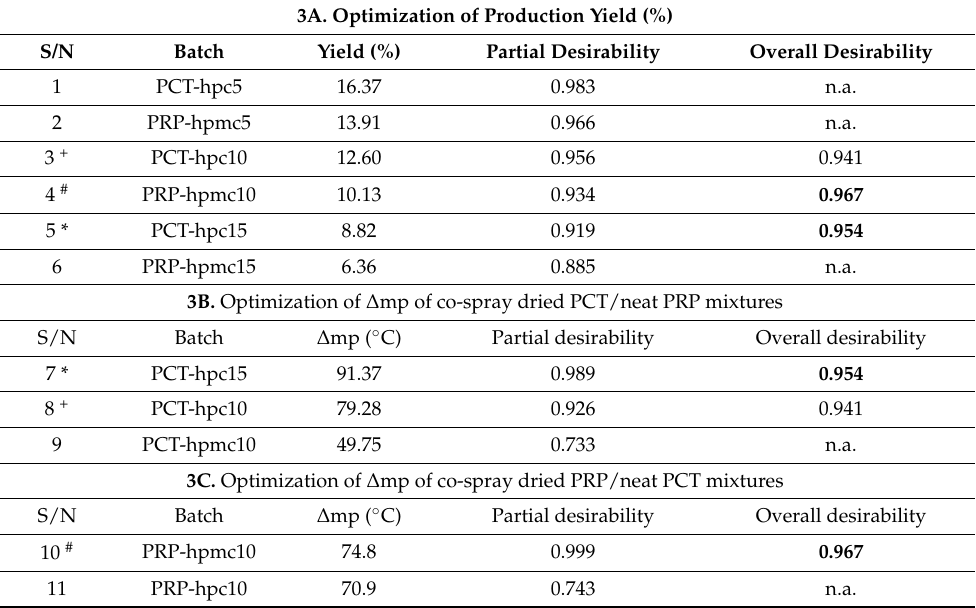
Table 4. Numerical solutions for optimization of spray drying production yield and melting point separation ( ∆ mp) obtained from the analysis of the experimental